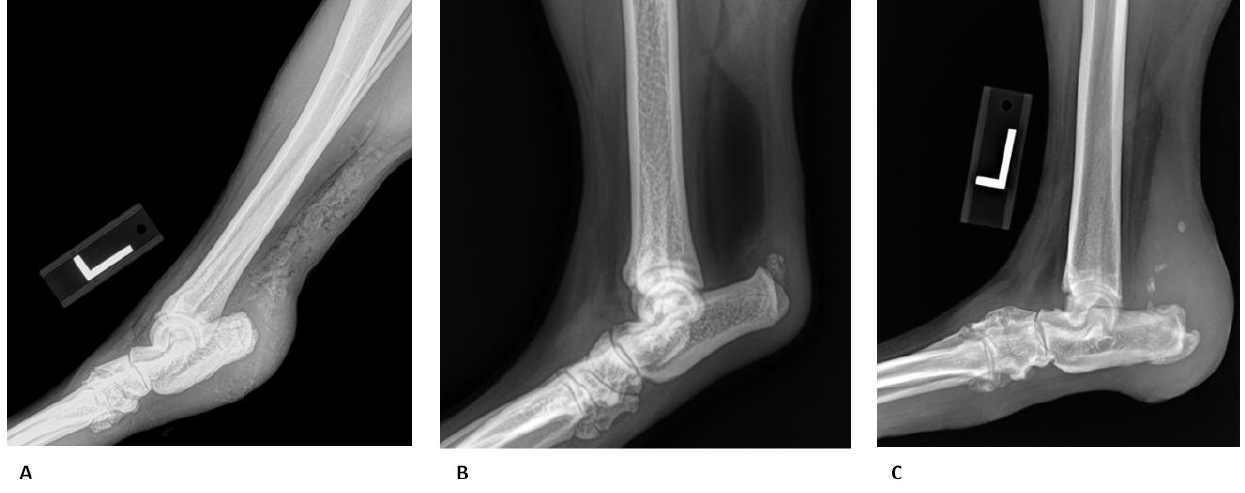
A- Hyperextended latero-medial view left tarsus Moderate to severe soft tissue swelling was noted at the insertion point of the Achilles’ tendon. Mild remodeling was present along the calcaneus at the insertion point of the Achilles’ tendon, mild calcification was also noted within the